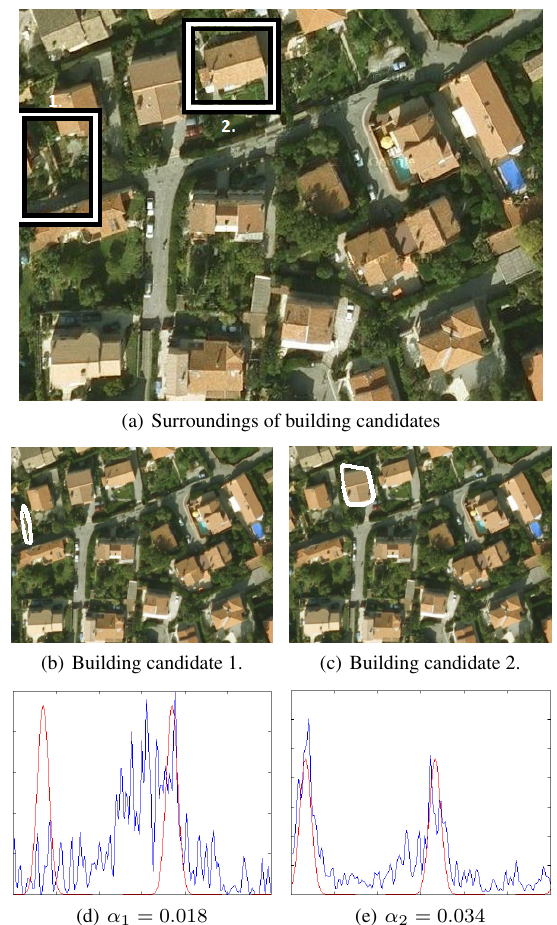
Figure 4: Elimination of false detection based on directional dis- tribution of edges in the extracted area: 1. area is a false detection, 2. area is a building. (b)-(c): Extracted areas by the graph-based connection process. (d)-(e): The calculated λ i ( ϕ ) directional dis- tribution and the resulting α values of the